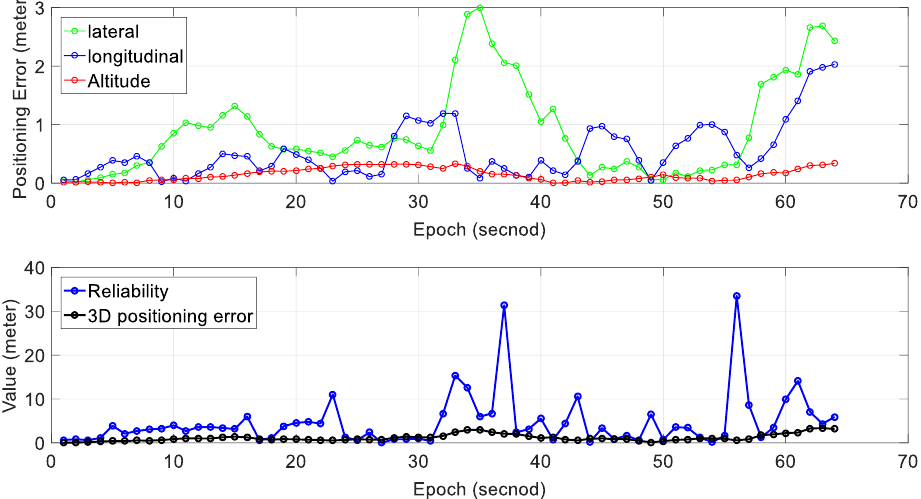
Figure A2. Experiment 5: positioning error and reliability estimation result. The top panel represents the positioning error in lateral, longitudinal and altitude directions, respectively. The bottom panel represents the estimated reliability and 3D positioning error of SLAM. Table A1. Experiment 5: Performance of NDT-based graph SLAM in a sub-urban area with normal traffic condition. 550